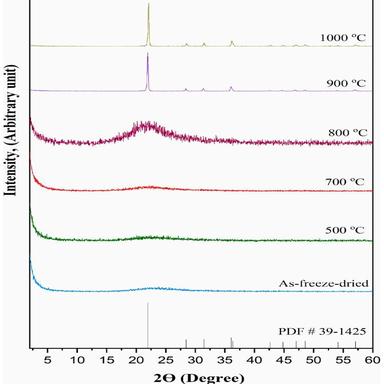
X-ray diffraction patterns of the as-freeze dried silica and samples calcined at 500 ◦C, 700 ◦C, 800 ◦C, 900 ◦C, and 1000 ◦C.